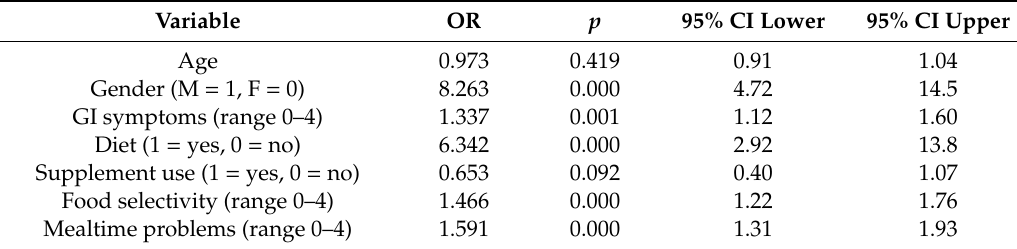
Table 7. Multivariate logistic regression analysis of factors associated with autism spectrum disorder (ASD). Variable